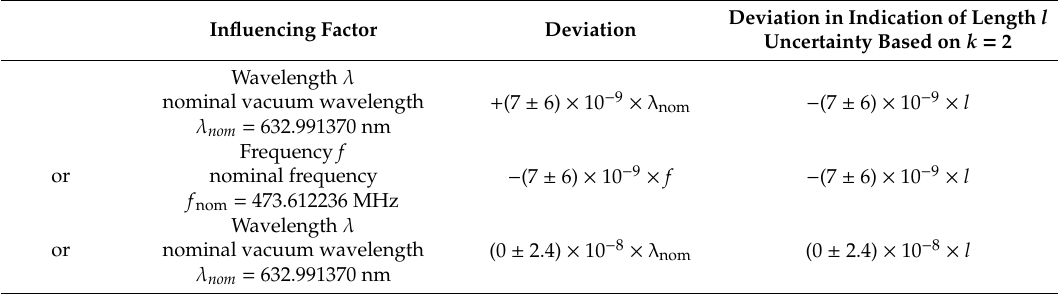
Table 2. Possible ways of reporting a frequency calibration as part of a laser interferometer system calibration.